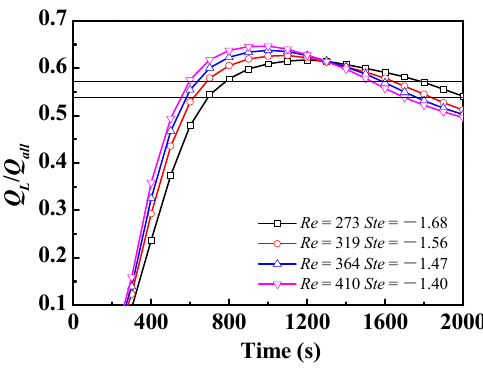
Figure 13. Time evolution of the outlet temperature at different inlet velocity ( Re )/inlet temperature ( Ste ) ( Re / Ste ) numbers under the given inlet power.